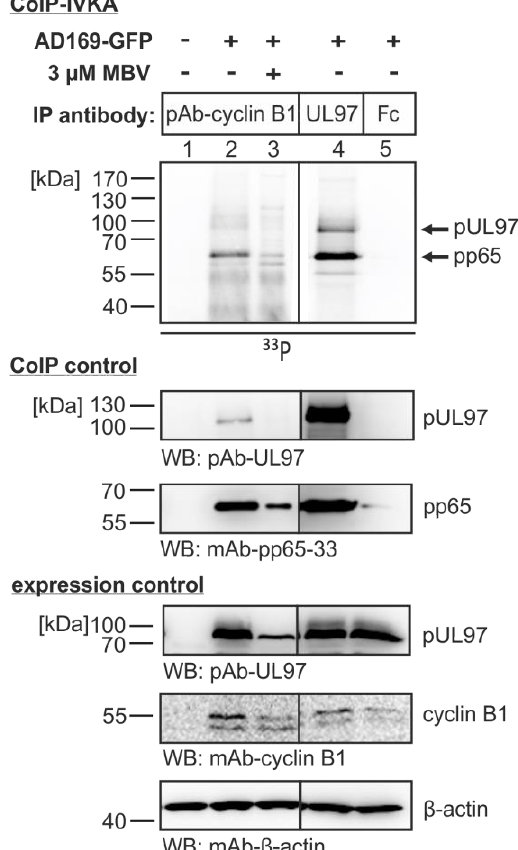
Figure 5. Combined coimmunoprecipitation- in vitro kinase assay (CoIP-IVKA) demonstrating the pUL97-specific phosphorylation of proteins in pUL97-cyclin B1